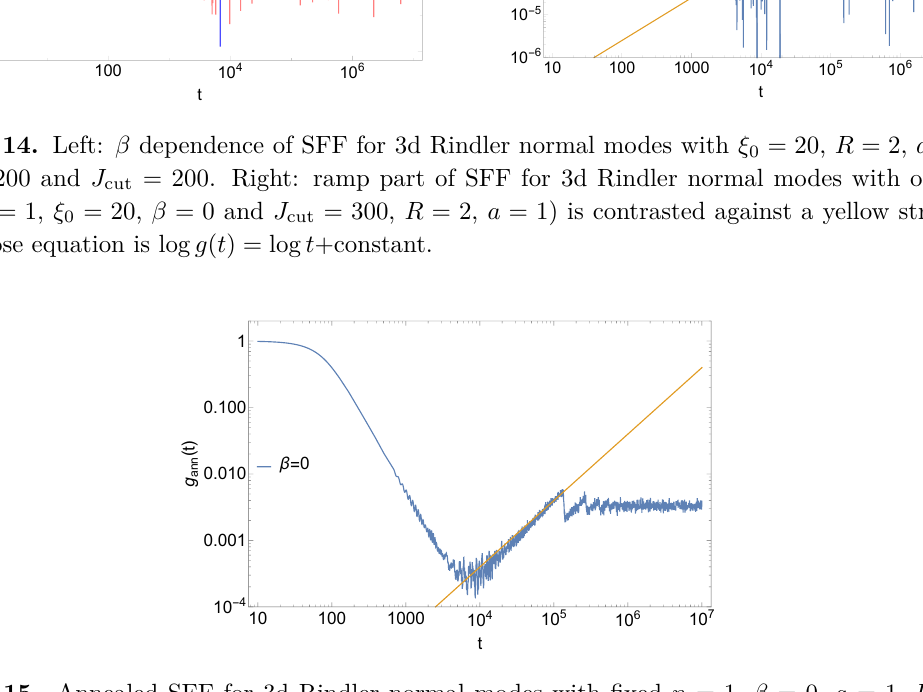
from a normal distribution 0